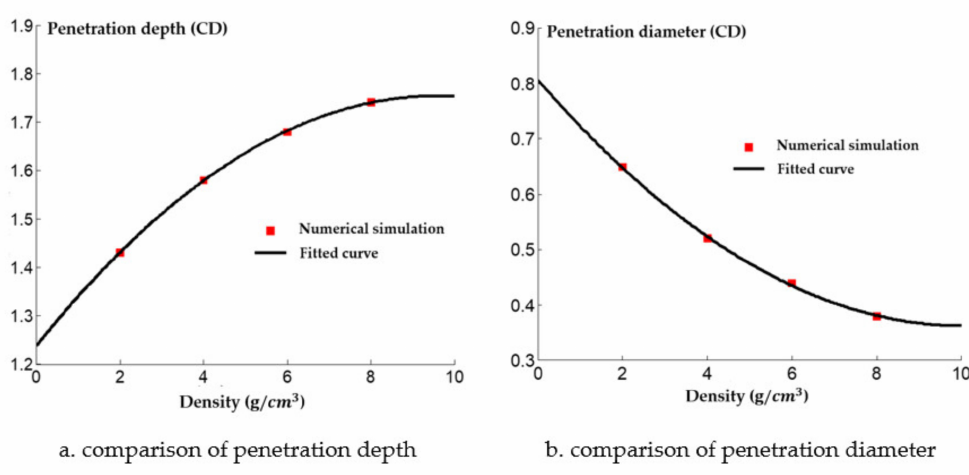
Figure 19. Penetration of reactive charge liners with different densities into a steel